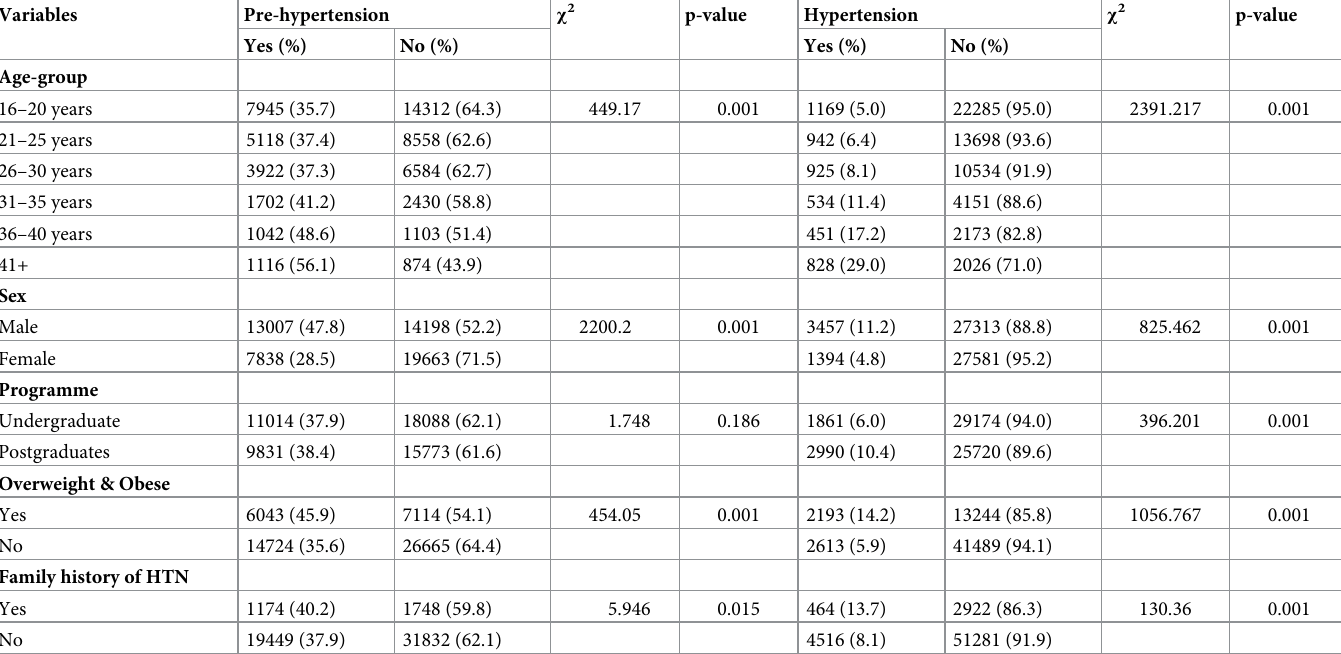
Table 6. Bivariate analysis showing the association between socio-demographic characteristics of students and pre-hypertension and hypertension.